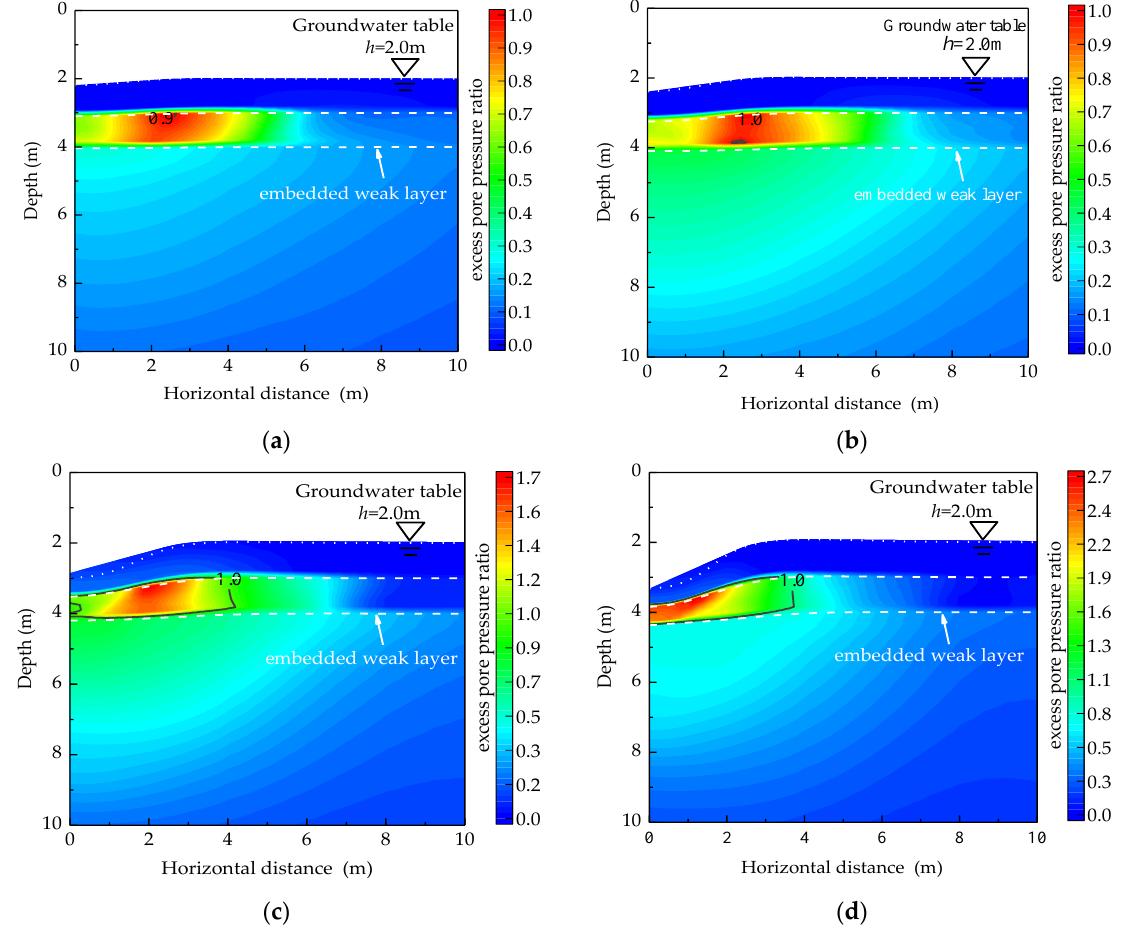
Figure 18. Cloud charts of excess pore water pressure ratio of embedded weak layer for different drop energy. ( a ) 1000 kN·m; ( b ) 2000 kN·m; ( c ) 3000 kN·m; ( d ) 4000 kN·m.